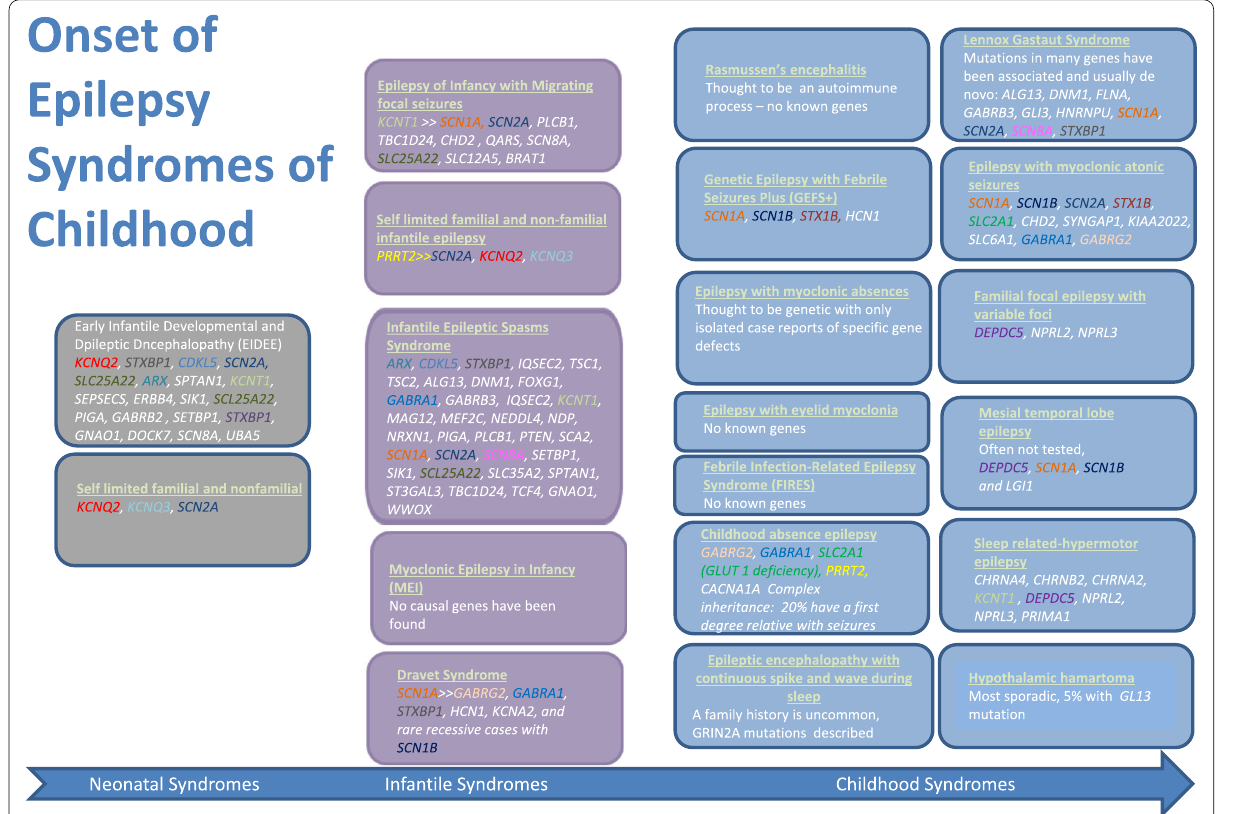
Fig. 1 Epilepsy syndromes presenting at different ages, and the most common genes associated with